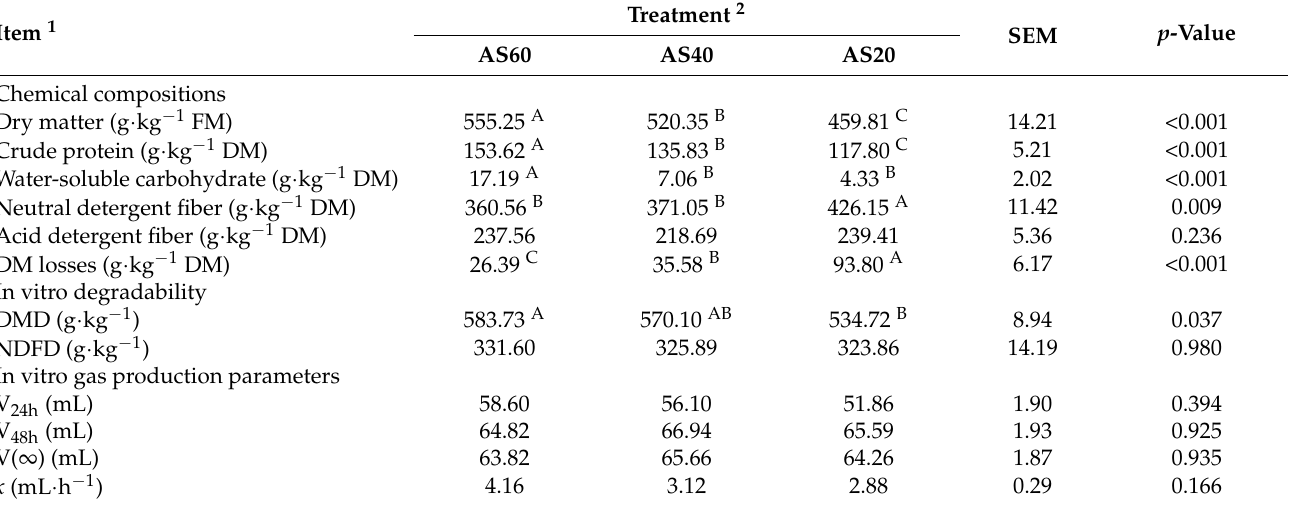
Table 4. Chemical compositions and in vitro digestibility of the TMR silages after 30 days of